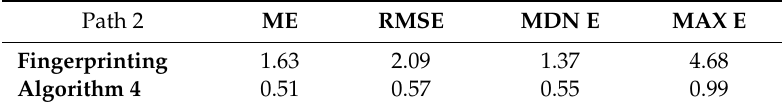
Table 3. Summary of test results for dynamic localization algorithms–path